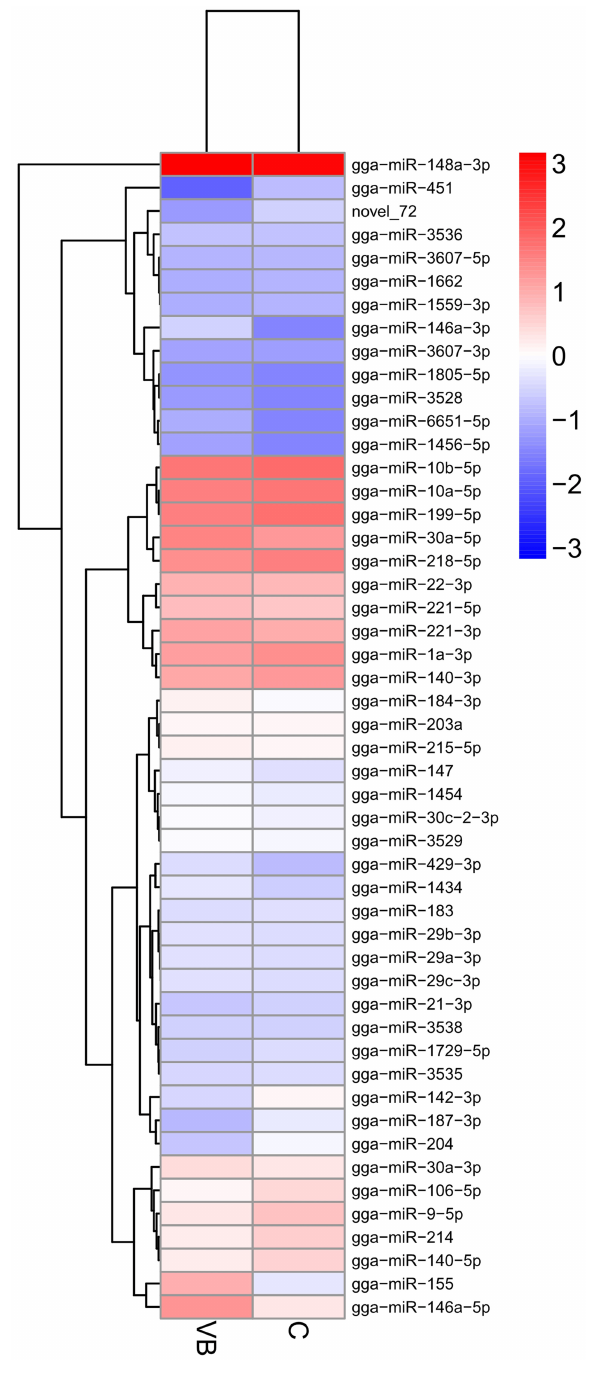
FIGURE 6 | Heatmap and sub-clusters of DEGs across two groups Expression values of two libraries are presented as fpkm normalized log 10 transformed